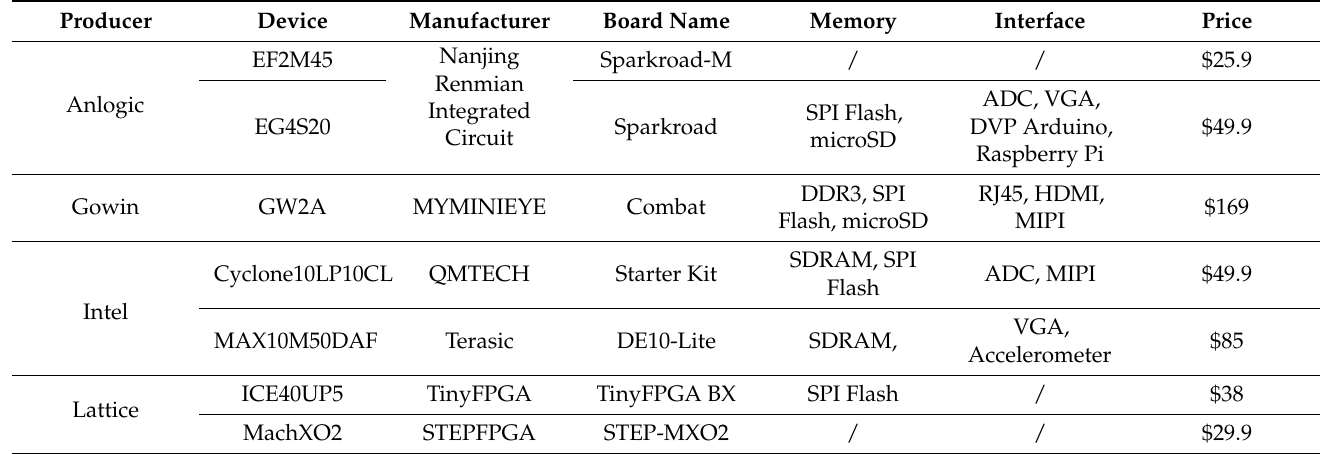
Table 4. The specification of 10 different FPGA